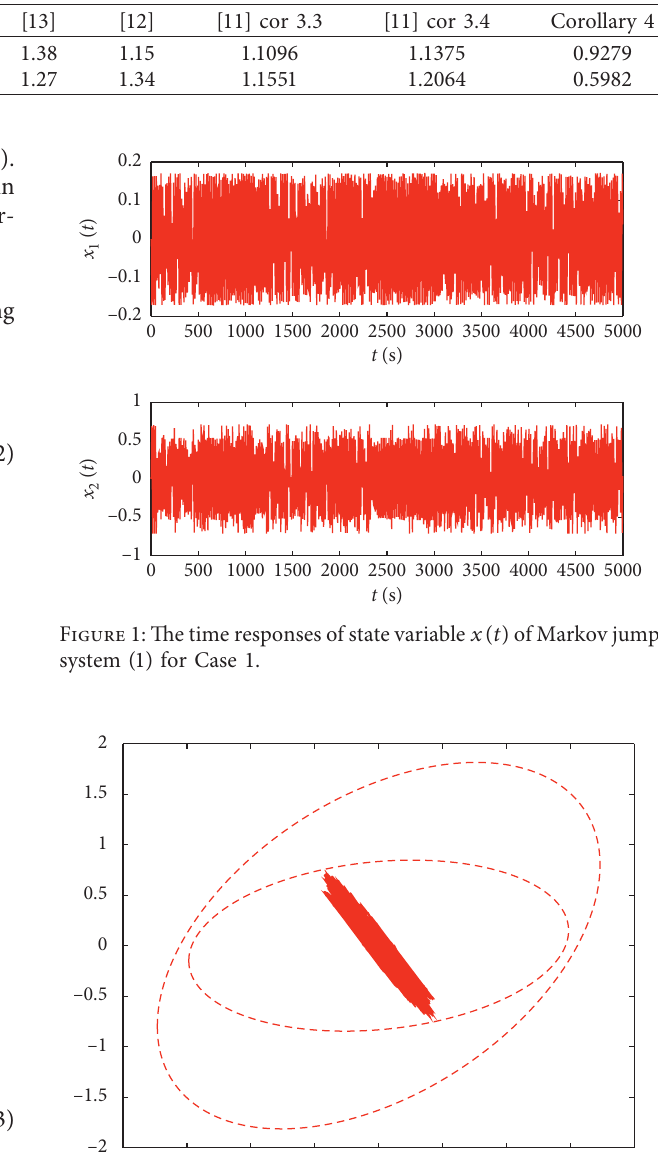
Table 1: The minimum sizes of ellipsoidal bound ( δ ) obtained by different